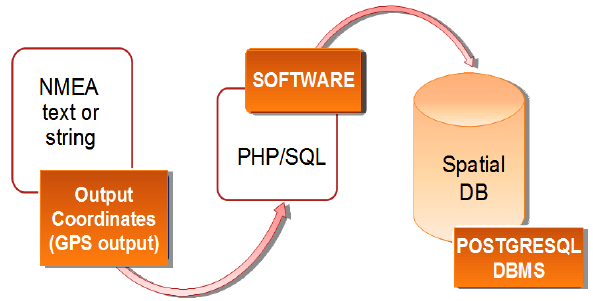
Figure 5. Transfer of GPS coordinates into the